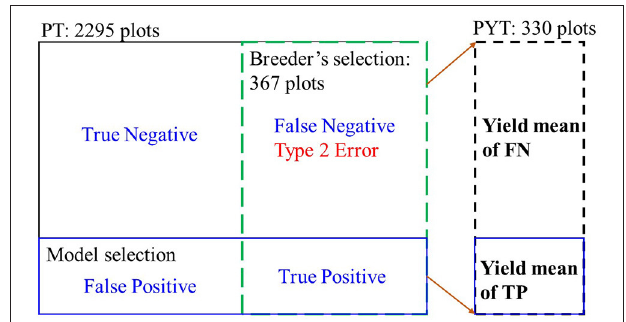
FIGURE 3 | Illustration of two metrics for evaluating model performance in selecting superior soybean breeding lines. The testing sets (20%) included 2,295 and 790 breeding lines for the PT and